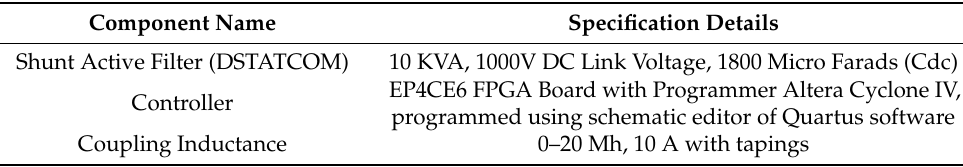
Figure 10. Experimental setup of DSTATCOM. Table 3. Hardware Components and their